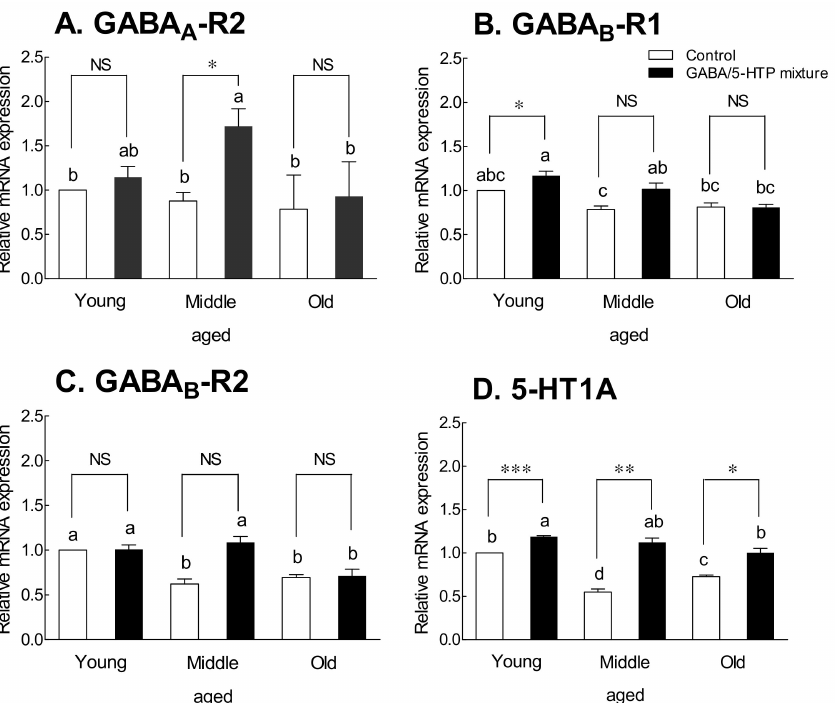
Figure 6. Effects of the GABA/5-HTP mixture (60 and 6 mg/kg, respectively, oral administration for 14 days) on age-related changes in mRNA expression of receptors: GABA A receptor ( A ), GABA B receptor 1 ( B ), GABA B receptor 2 ( C ), and 5-HT1A receptor ( D ). Young (6 weeks), middle-aged (6 months), and old (1 year) mice were used. Data are presented as means ± standard error of the mean for each group ( n = 5 per group; control: 0.9% physiological saline group). The different letters indicate significant ( p < 0.05) differences from the control group by Tukey’s test. Symbols indicate significant differences at * p < 0.05, ** p < 0.01, and *** p < 0.001 as compared with the control group by Student’s t -test. NS, not significant.